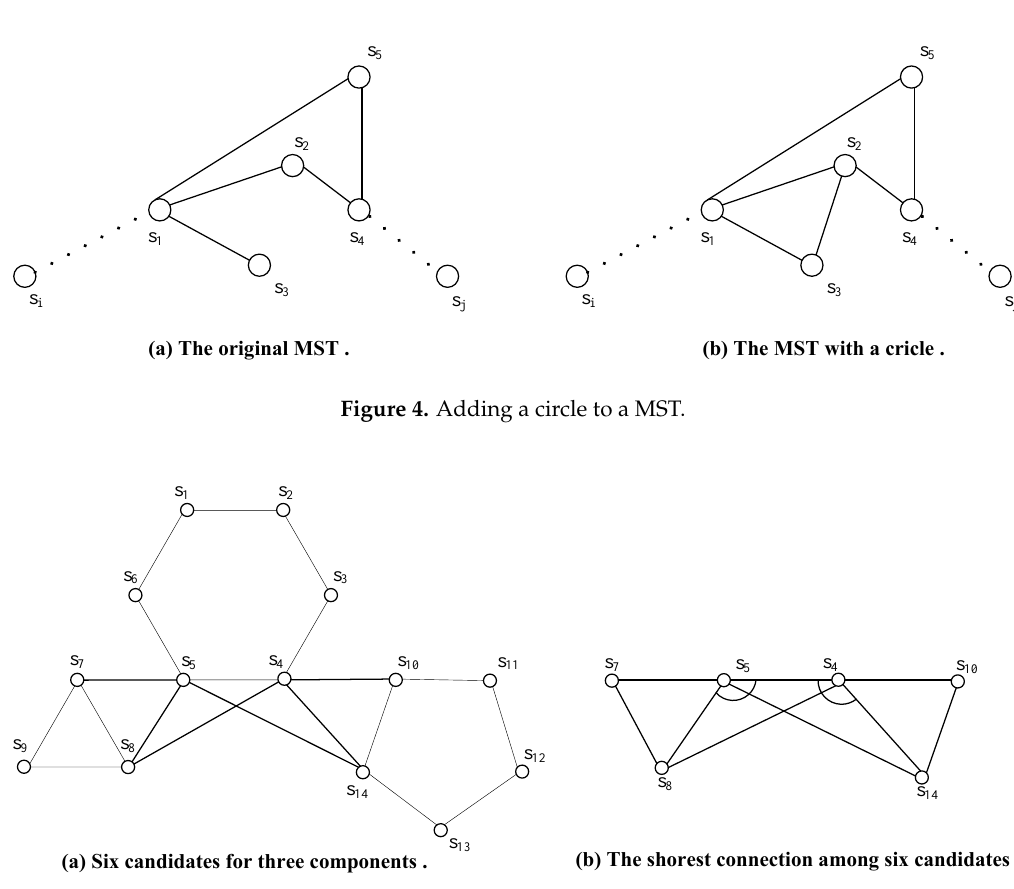
Figure 5. The representative